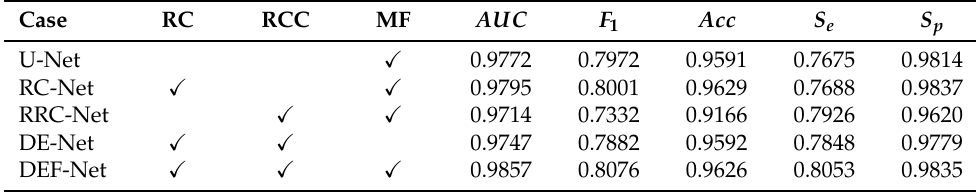
Table 2. Ablation experiment on CHASE_DB1 dataset.